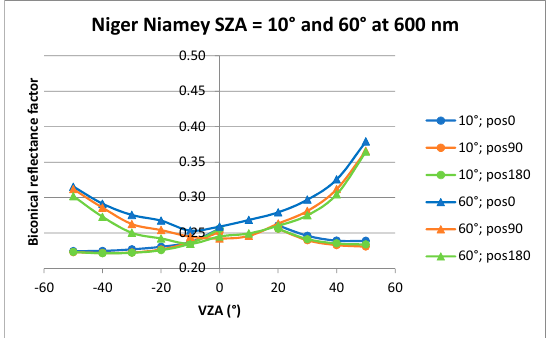
Figure 15. BCRF for the minimum (10°) and the maximum (60°) solar zenith angles, in the principal plane, for Nigerian site near Niamey.